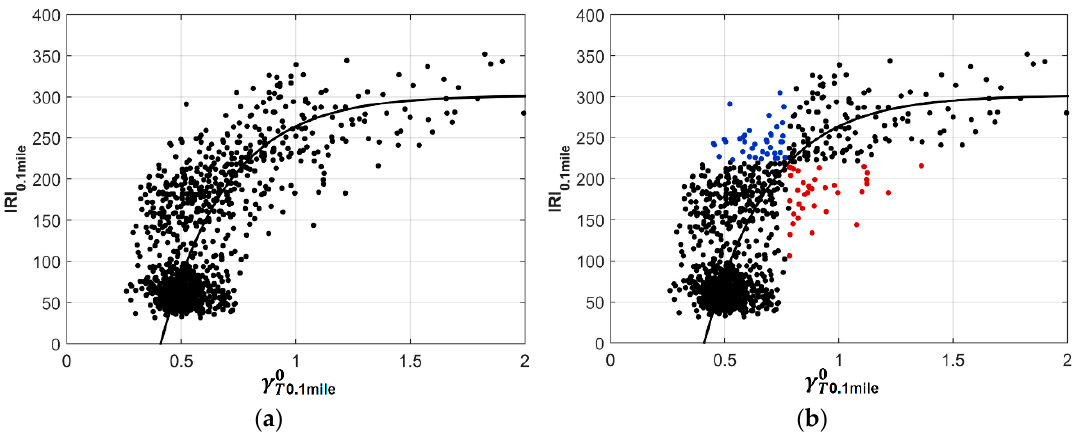
Figure 6. ( a ) Signal model describing the relationship between 𝛾 (cid:3021)(cid:2868) locations belonging to the training set are used; ( b ) type-I (blue) and type-II errors (red) of road surface classification from SAR for a detection threshold of 𝐼𝑅𝐼 (cid:3047)(cid:3035)(cid:3045)(cid:3032)(cid:3046)(cid:3035) = 220 𝑖𝑛𝑐ℎ𝑒𝑠 𝑚𝑖𝑙𝑒⁄ .